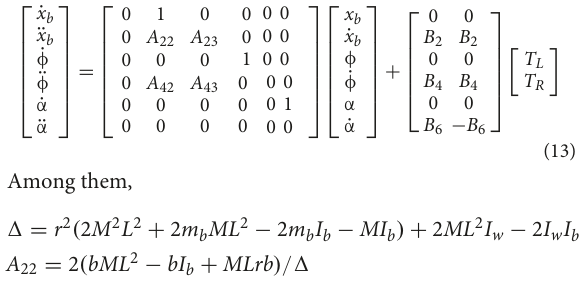
FIGURE4 Force diagram of equivalent